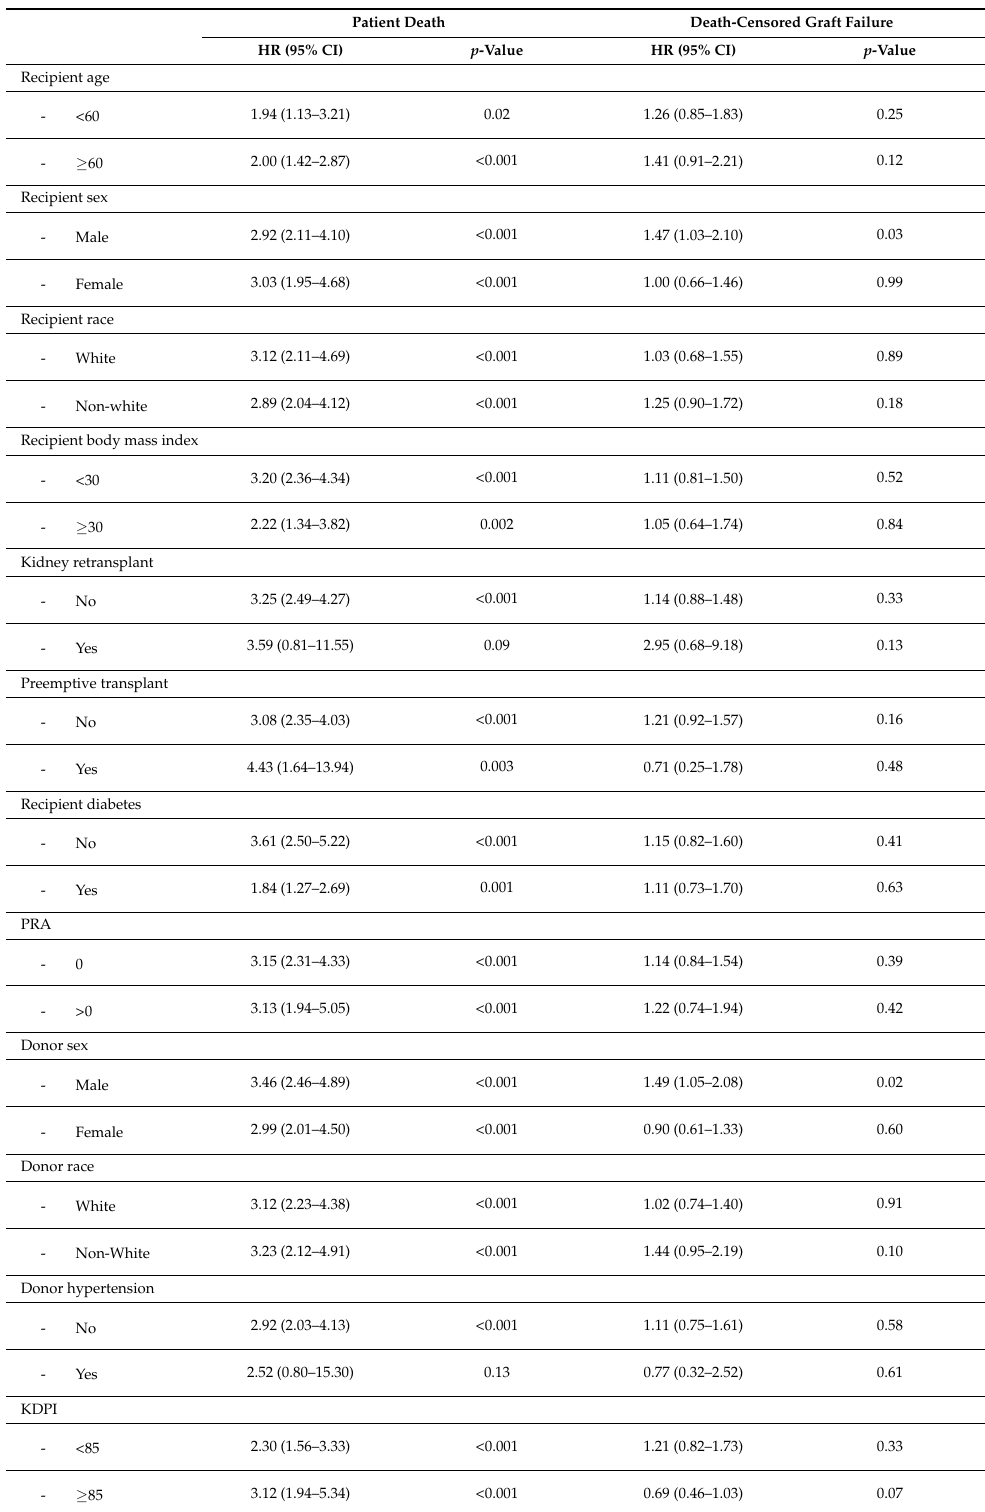
Table 3. Subgroup